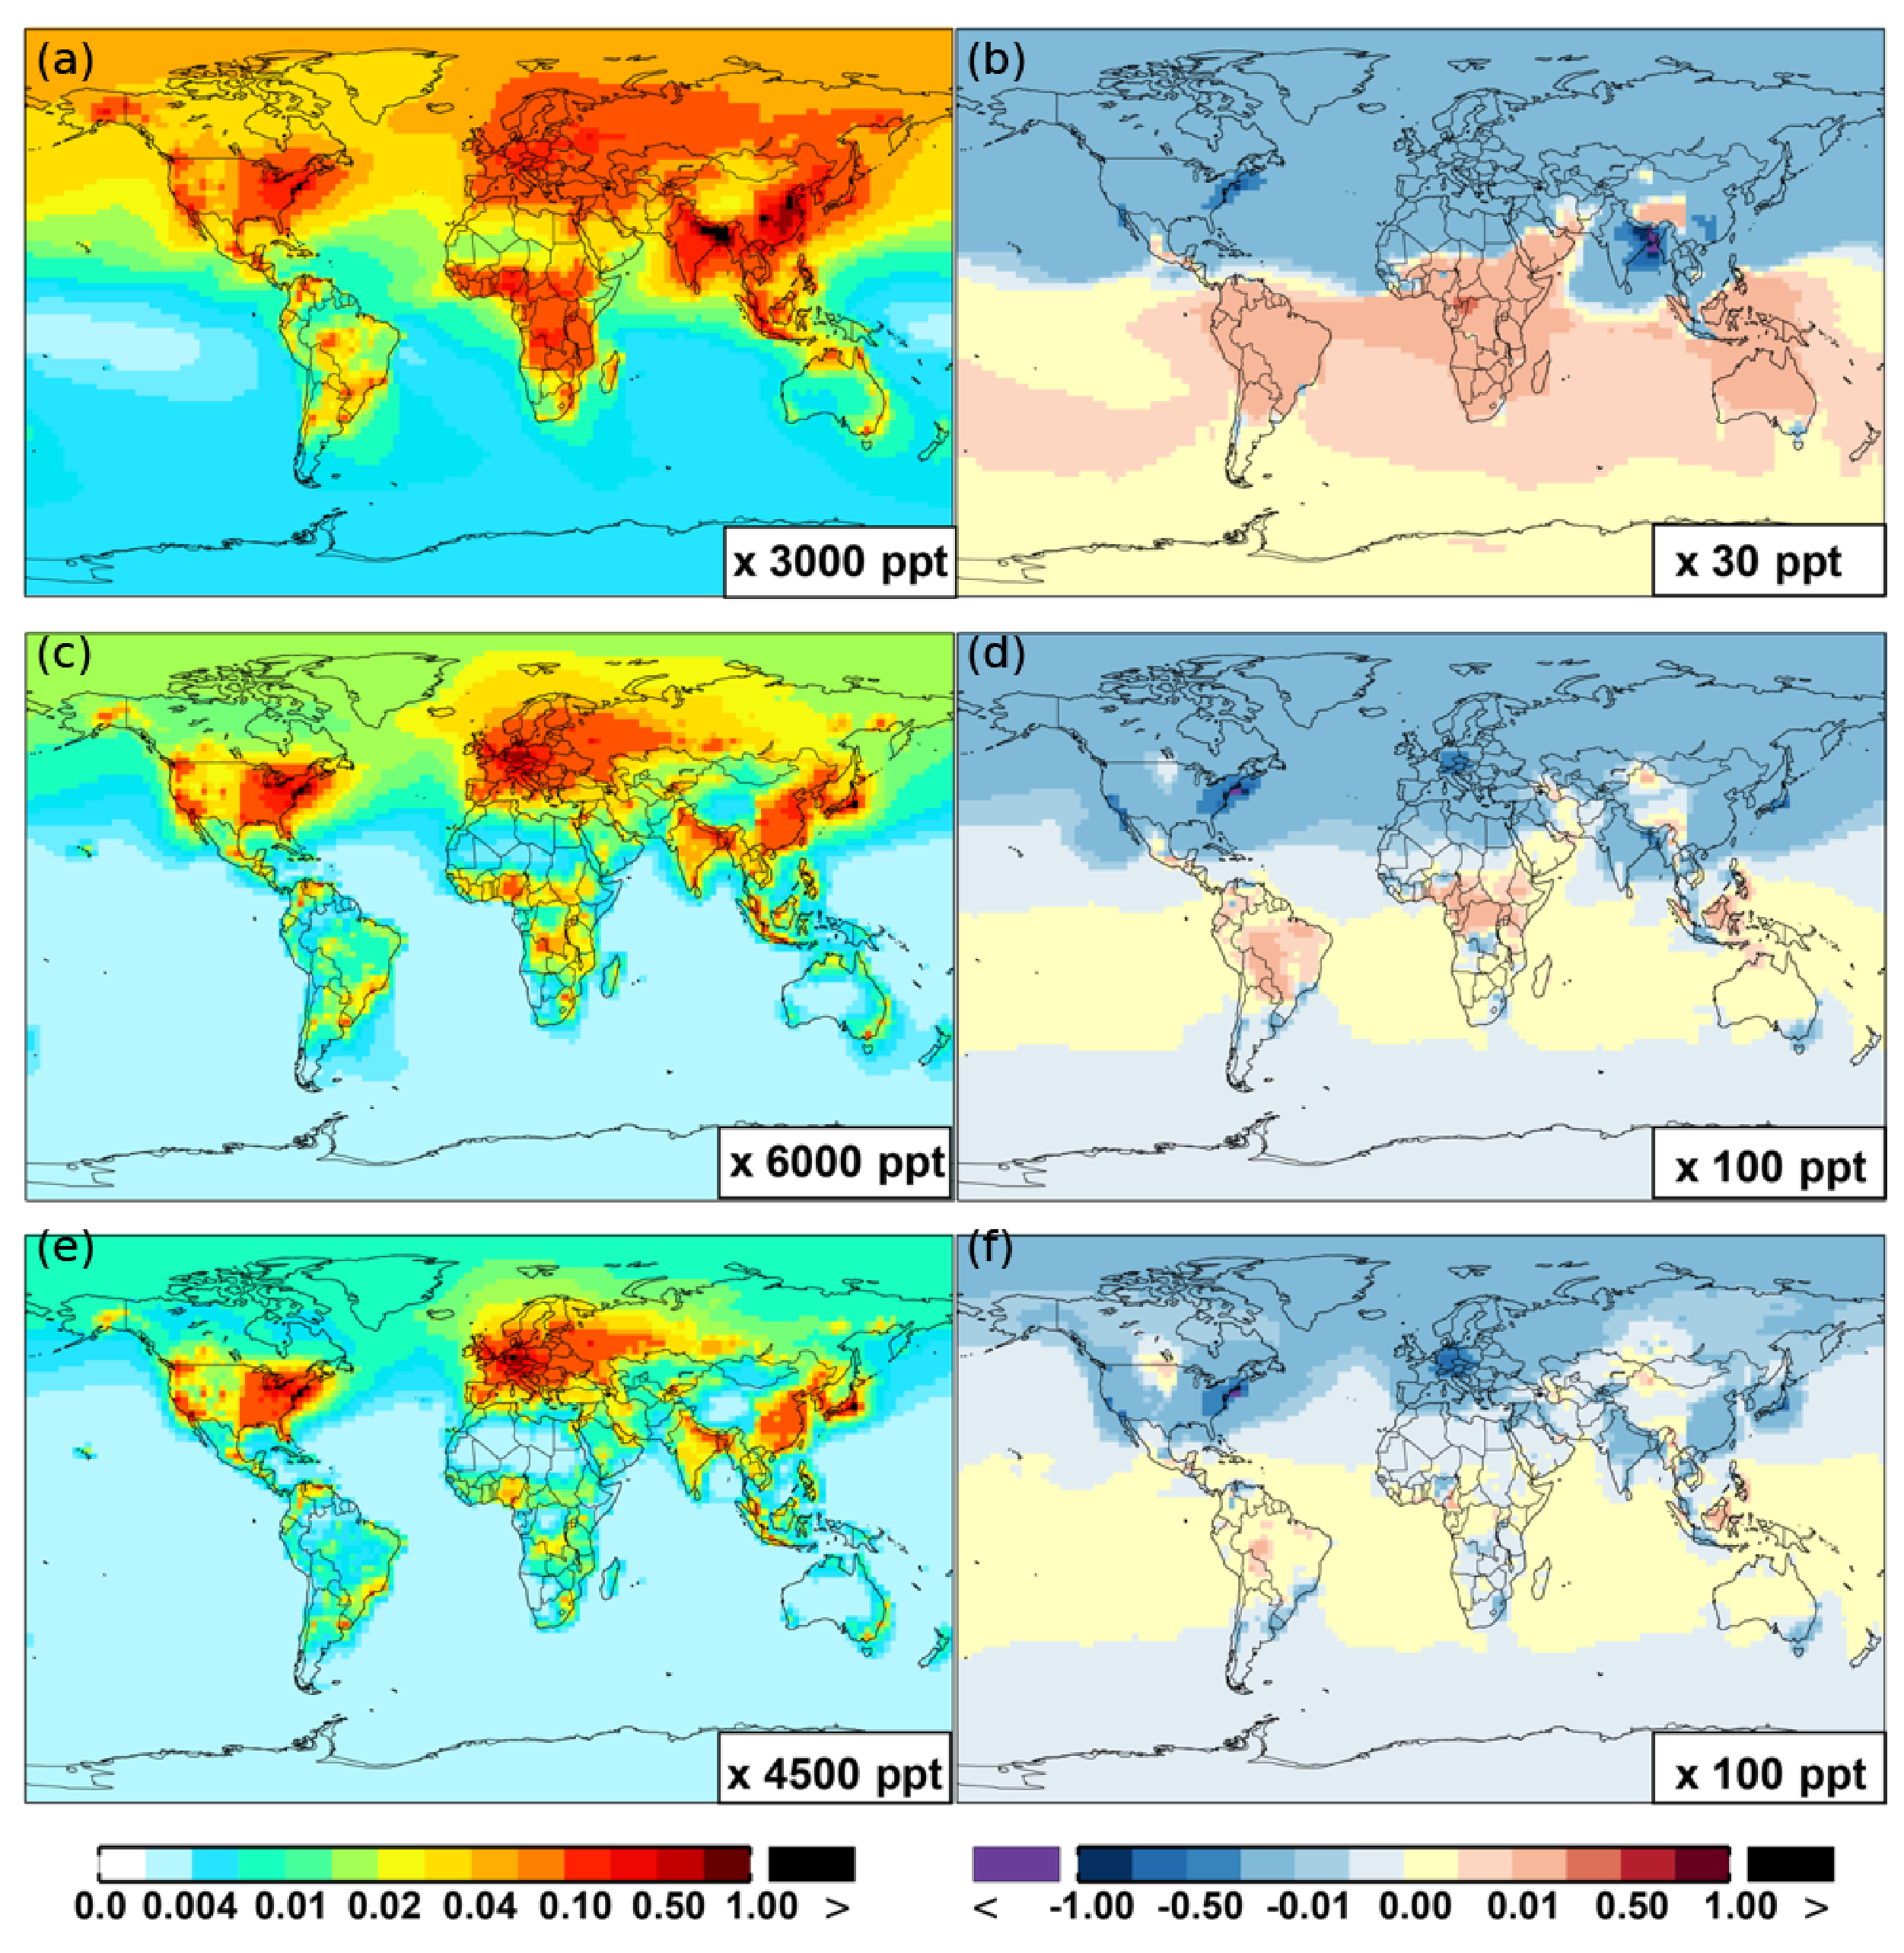
Same asFig. 6 but for benzene (a, b), toluene (c, d), and xylene (e, f).